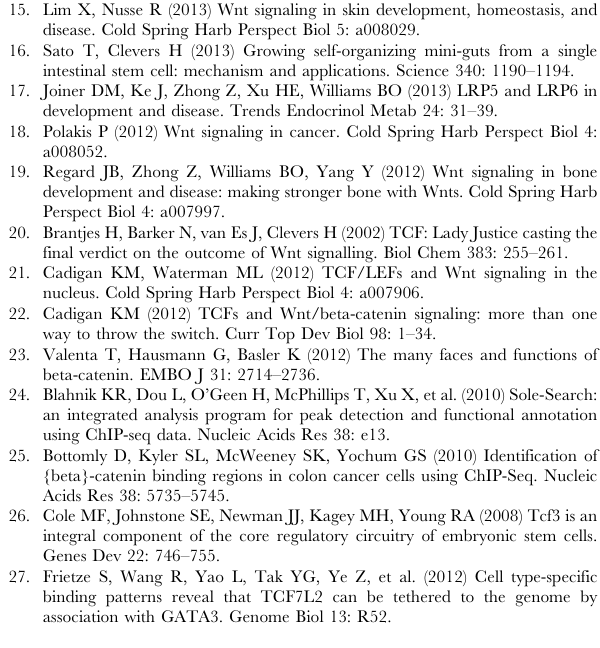
HMG-Helper pairs in TCF/Pan bound and random DNA (see Figure 7 and text for further explanation). HMG-Helper pairs are , 2.4 times more likely to occur in TCF/Pan bound regions than in random DNA (2139 hits vs 893.1). Figure S5 HMG-Helper pairs are less enriched in TCF/Pan bound regions shared by other cardiogenic TFs. TCF/Pan bound peaks were divided into groups based on whether the center of the peak was located within 150 bp of the peak for another TF. HMG-Helper pair enrichment is much greater in ‘‘unique peaks’’ than in shared peaks. The difference is especially evident in the FF0-2 and AK0-6 range. A subset of this data is shown in Figure 7B. Figure S6 The optimized nkd UPE2 reporter is Wg signaling dependent. (A,B) Bright field images of wing imaginal discs from late 3 rd larval instar from animals containing the optimized nkd UPE2 reporter, Dpp -Gal4, TubGal80ts without (A) or with (B) UAS-TCF DN . Animals were shifted from 18 u C to 29 u C for 48 hr prior to dissection. The reporter gene is severely repressed at the anterior posterior boundary, where the Dpp-Gal4 is active. Figure S7 In silico search for FF1 HMG-Helper site pairs. (A) Training sequences and PWM used in a search of Chromosome arm 3R. (B) List of the top 23 hits, location and genomic environment. Figure S8 Da-Gal4 . UAS-ArmRNAi embryos secrete cuticle with hallmarks of reduced Wg signaling. Darkfield micrographs of end stage embryo cuticles from animals containing a P[ da -Gal4] transgene and control (A) or P[UAS- arm RNAi] chromosome (B). The Arm depleted embryos have extra denticles indicative of a partial loss of Wg signaling [63,71], but lack the gross abnormalities associated with a loss of cell adhesion [69,70].